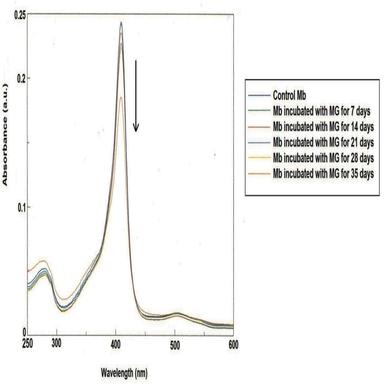
Absorption spectroscopy. Absorbance spectra of control Mb ( ) and Mb incubated with MG for 7 days ( ), 14 days ( ), 21 days ( ), 28 days ( ) and 35 days ( ) recorded in the 250–600 nm range. (For interpretation of the references to color in this figure legend, the reader is referred to the web version of this article.)